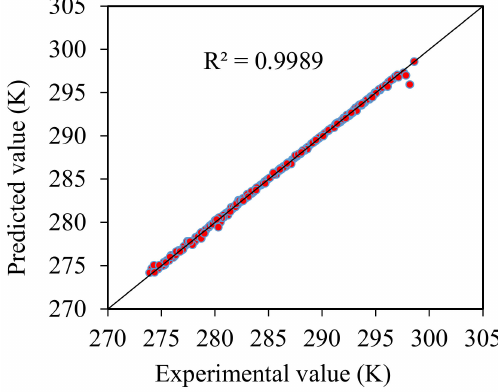
Figure 3. Test results for the GA-SVM